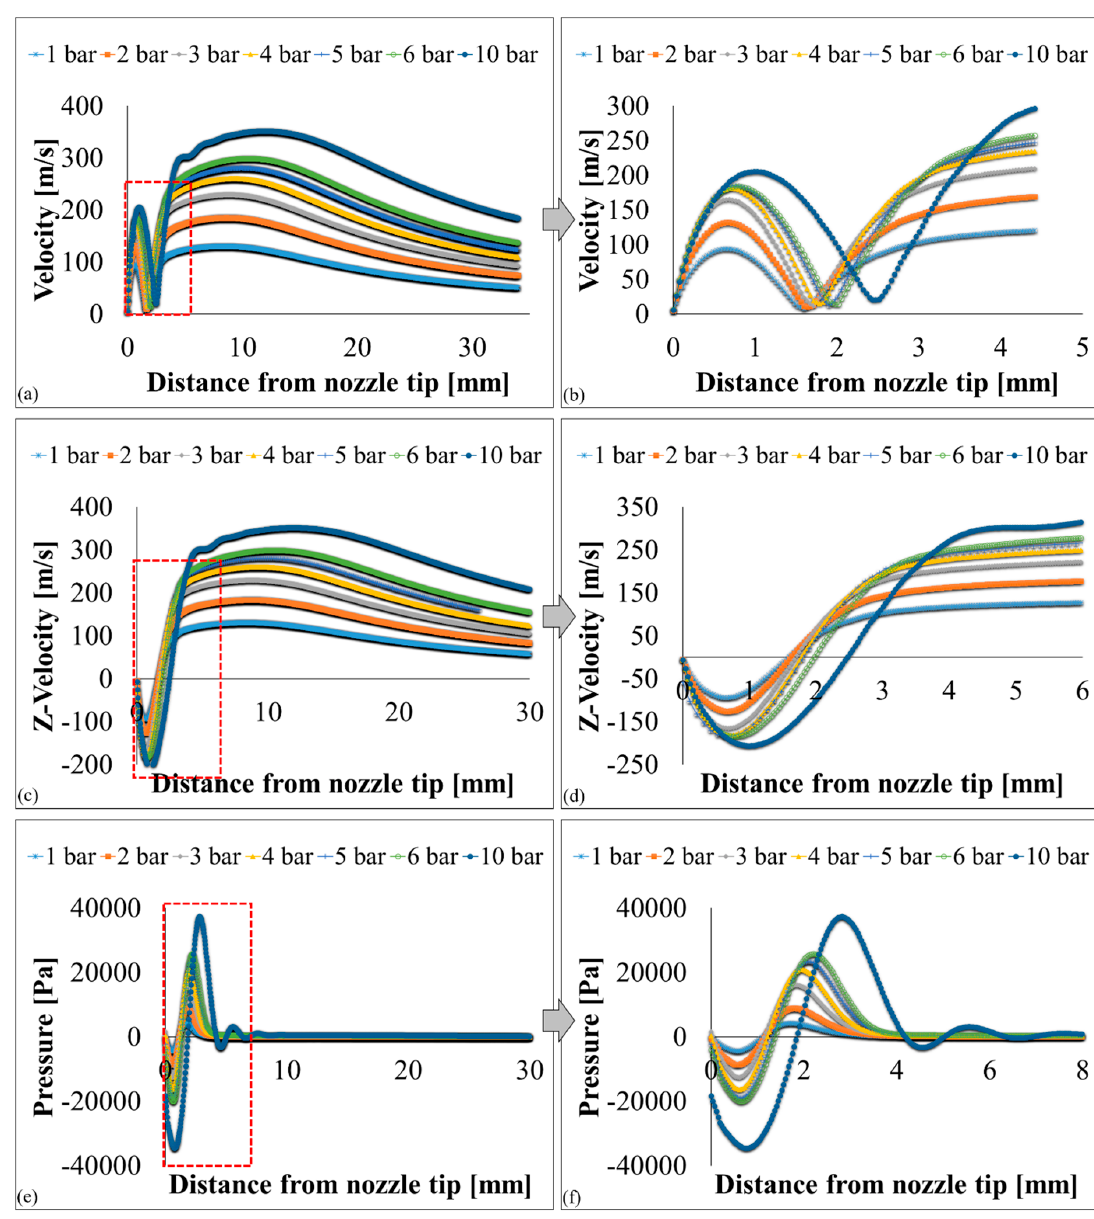
Figure 12. k- ε turbulence flow plots through SBS nozzle at different air pressures: ( a , b ) velocity (m/s), ( c , d ) z-velocity (m/s), and ( e , f ) pressure (Pa).